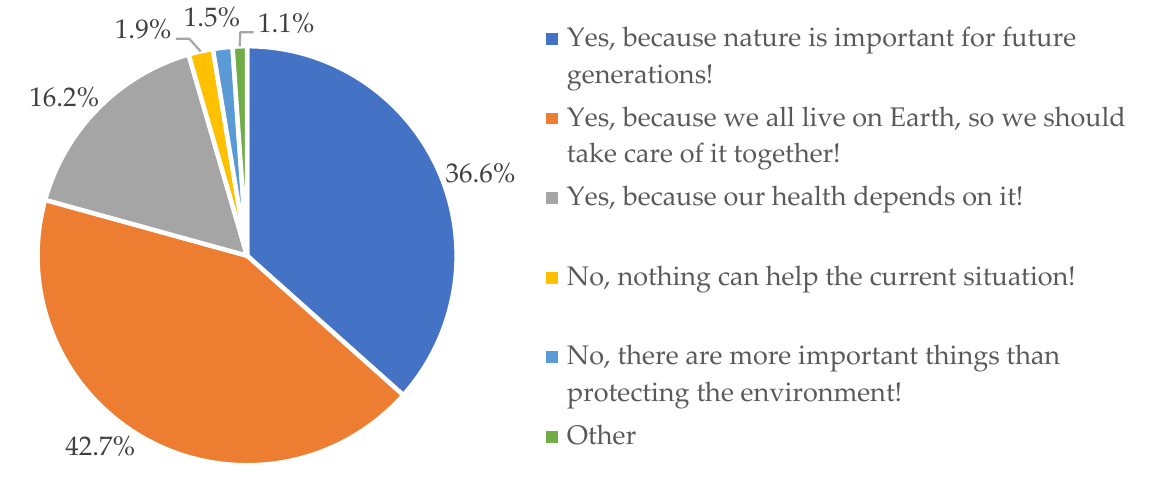
Table 5. The statistical relationship values for relation between the number of classes and the perceived importance of environmental